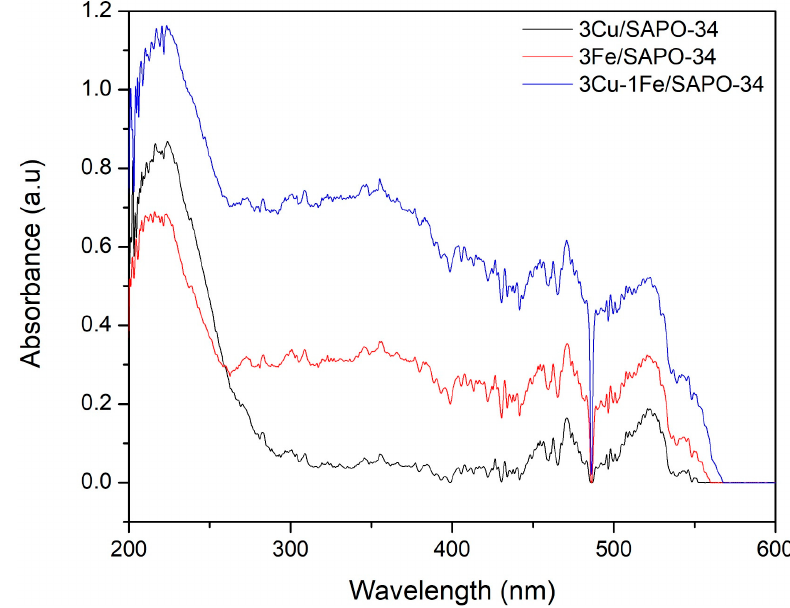
Figure 6 . UV–Vis DRS spectra of the Cu/SAPO-34, Fe/SAPO-34 and Cu-Fe/SAPO-34 samples. Figure 6. UV–Vis DRS spectra of the Cu / SAPO-34, Fe / SAPO-34 and Cu-Fe / SAPO-34